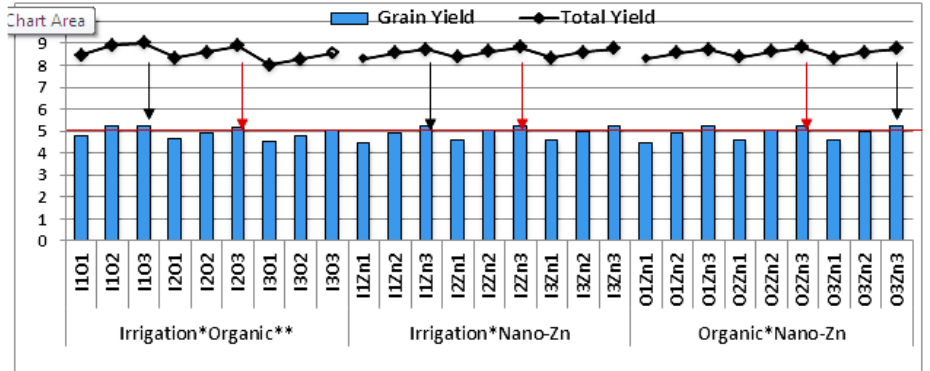
Figure 4. The bilateral interaction effect of irrigation supplements, organic amendment, and nano-Zn foliar spraying on yield (average data over the two studied seasons). *: refers to significant, and **: refers to highly significant differences between them ( p < 0.05, 0.01).